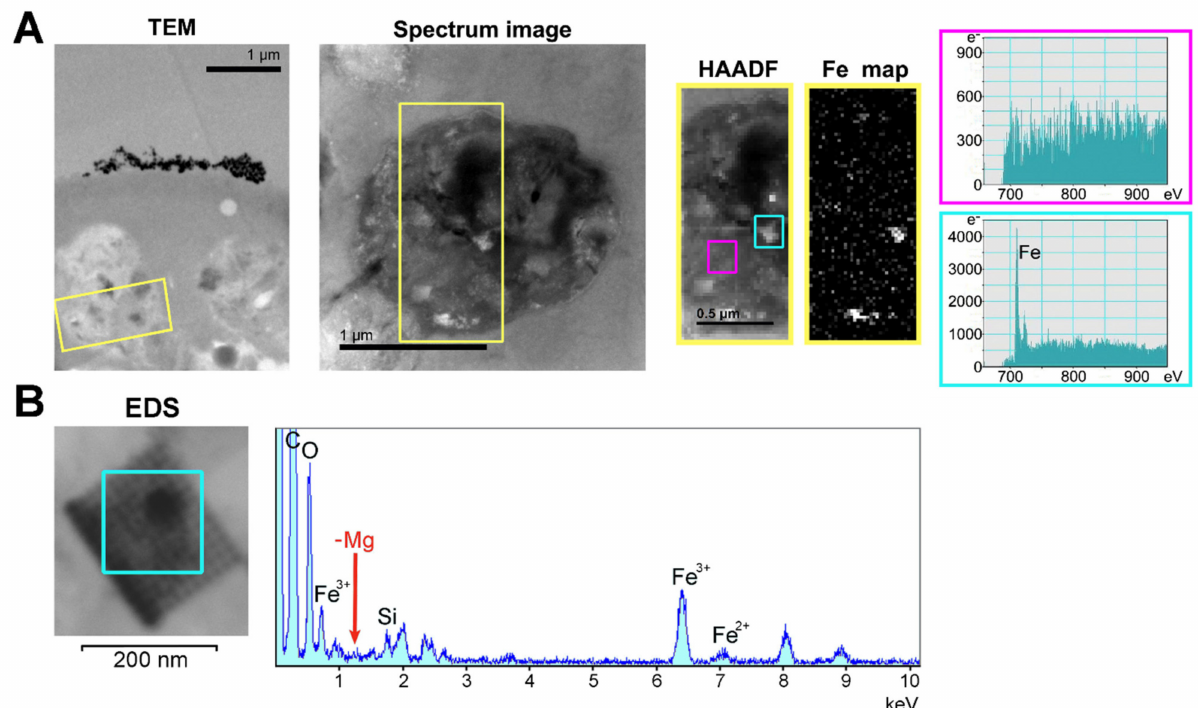
Figure 9. Identification of the ferric ion-containing granules in H. dujardini cells. ( A ) Transmission electron microscopy of the fragment of sponge cell with inclusions. HAADF and Fe map panels represent the area outlined in yellow on the panel Spectrum image which in turn is a section of the TEM panel. The spectra outlined in cyan and magenta were taken from the corresponding outlined areas in the HAADF panel. Scale 1 µ m. ( B ) EDS-analysis of the region where the presence of iron atoms was confirmed by the HAADF method. TEM image of this area in higher resolution is shown in Figure S7. Spectrum data for the plot can be seen in Supplementary Table